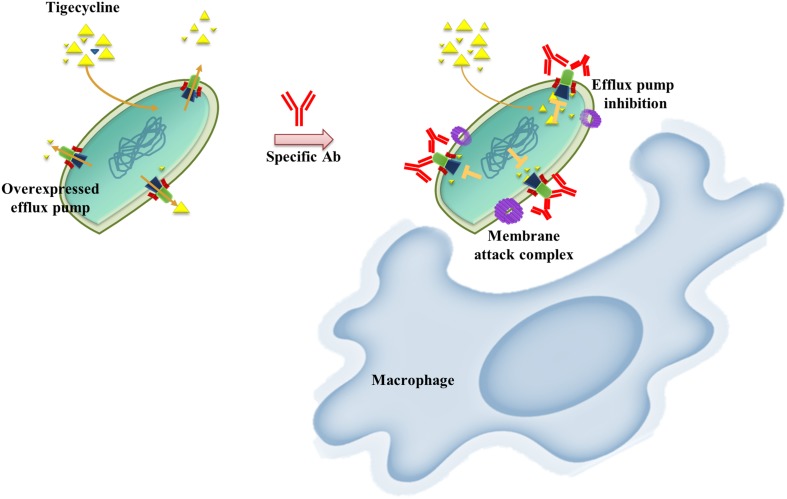
Schematic representation of the proposed mechanism of anti-efflux antibodies-mediated tigecycline efflux inhibition and bactericidal activity. Under overexpressed conditions, activated efflux pumps efficiently remove tigecycline to attenuate antibiotic activity (left). These phenomena might be restored by using an anti-rAdeK antibody as an efflux pump inhibitor. Bactericidal effects might also be induced via complement-mediated lytic membrane attack complex pores and opsonophagocytic activity (right).